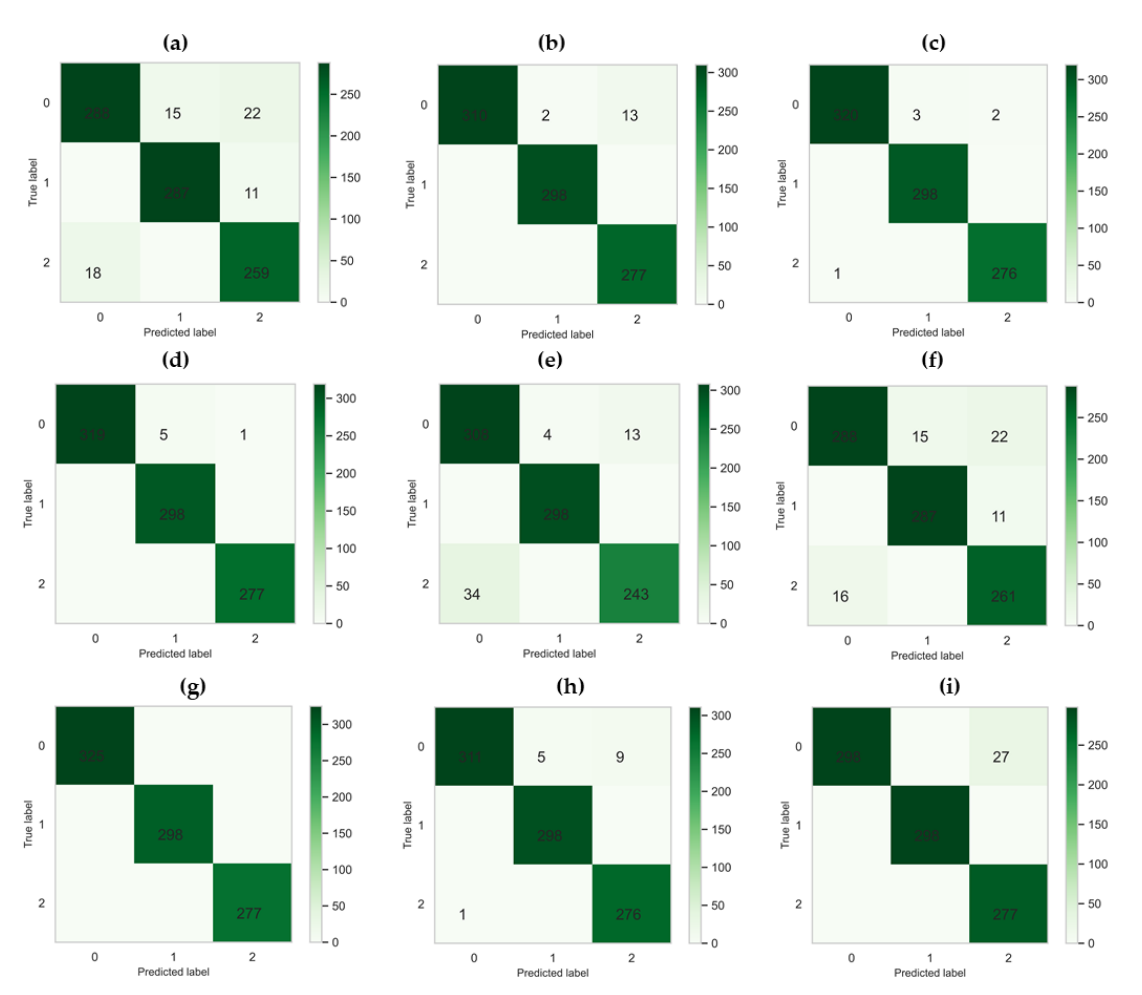
Figure 15. Confusion Matrix of the selected models ( a ) MLP ( b ) DT ( c ) KNN ( d ) RF ( e ) SGD ( f ) LR ( g ) GB ( h ) SVC ( i )